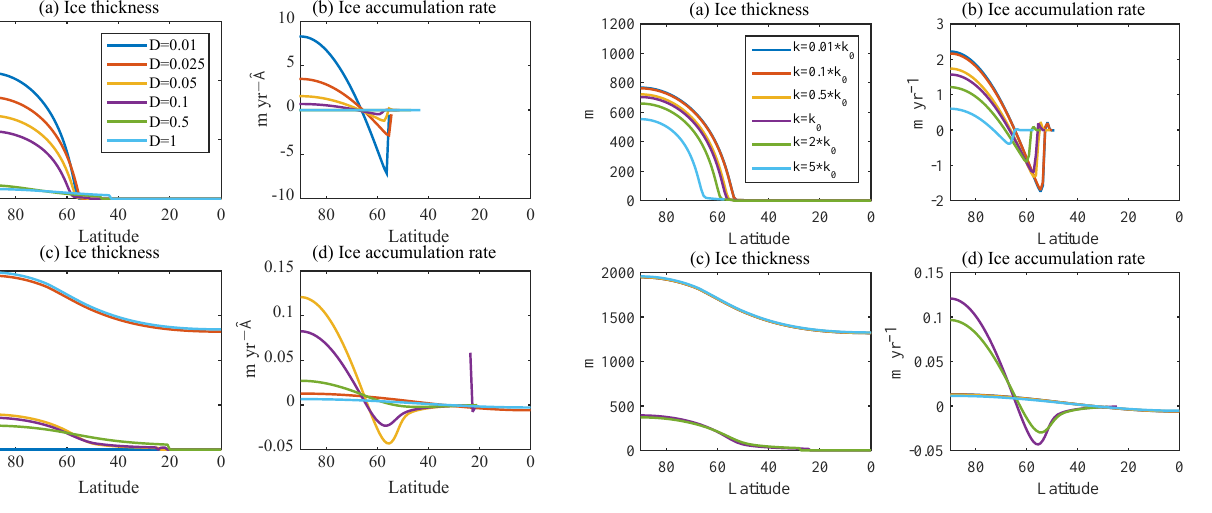
Figure 6. Effect of k 0 parameter on small ice cap regime (top) and large ice cap regime (bottom). Smaller circulation constants reduce heat transport from the tropics to the poles, thereby facilitating ice growth. The large ice cap instability is again reflected in the sensi- tivity to changes to the hydraulic constant, with the shown devia- tions resulting in Snowball